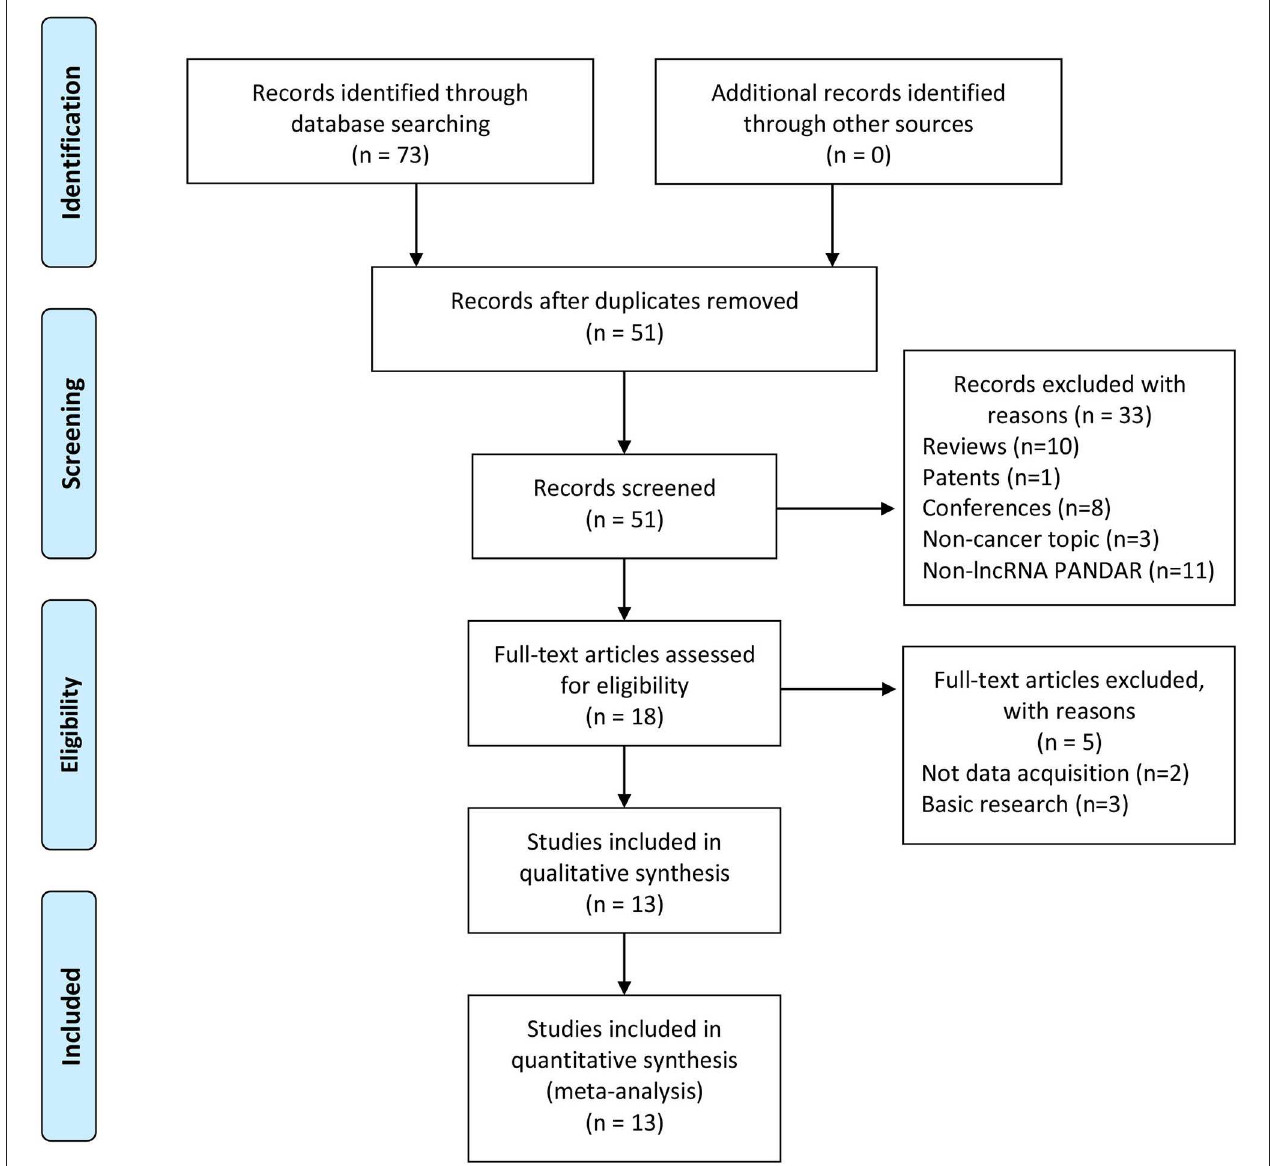
FIGURE 1 | The selection flow chart of our systematic review.